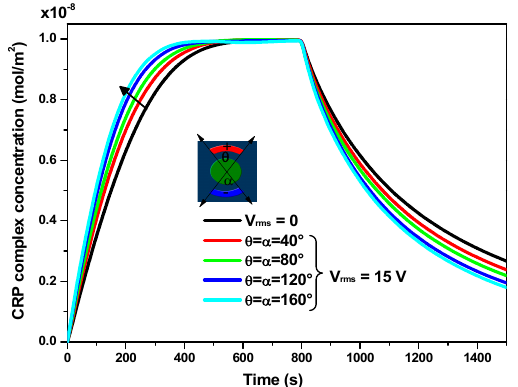
Figure 5. Temporal evolution of the average surface complex concentration for different values of the electrode aperture angles with applied voltage V rms = 15 V. Four values of the angle θ = α (namely, 40, 80, 120, and 160°) are considered. The average inlet velocity is fixed at 100 μ m/s. Table 5 illustrates the initial slopes for association and dissociation binding reaction corresponding to four values of the electrode aperture angles θ and α . The initial slope was calculated by choosing few points near the initial time of each phase (i.e., near 𝑡 (cid:3404) 0 𝑠 for the association phase and near 𝑡 (cid:3404) 800 𝑠 for the dissociation phase). Then, a linear interpolation based on the least square method was used to compute the slope. The slope of the curves gives the binding rate and is related to the response time of the biosensor.